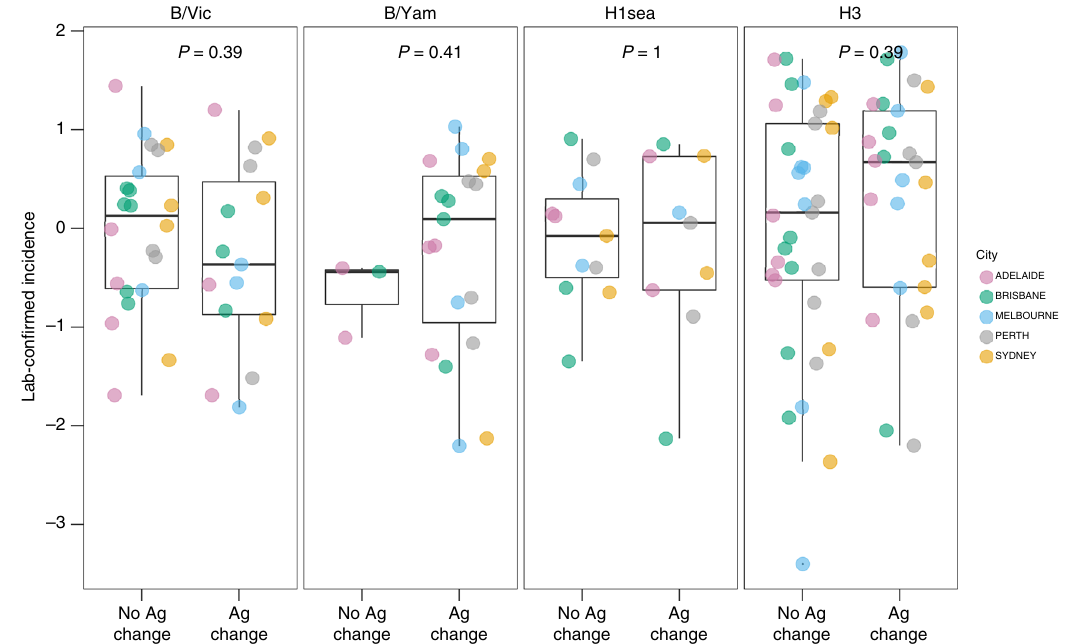
Fig. 3 Effect of antigenic change on epidemic incidence. Epidemic incidence was compared between seasons associated with and without the epidemic- level circulation of a new major antigenic variant. Within each subtype, the incidence for individual epidemics was log-transformed and subtracted by the city-speci fi c mean of log incidence, to allow for comparison between cities. P values are from Wilcoxon two-sample tests ( n = 37, 26, 22 and 63 for B/Vic, B/Yam, A/H1sea and A/H3, respectively). Each point corresponds to one epidemic in a city, and the box plots show the median, fi rst and third quartile of the transformed values, and range.